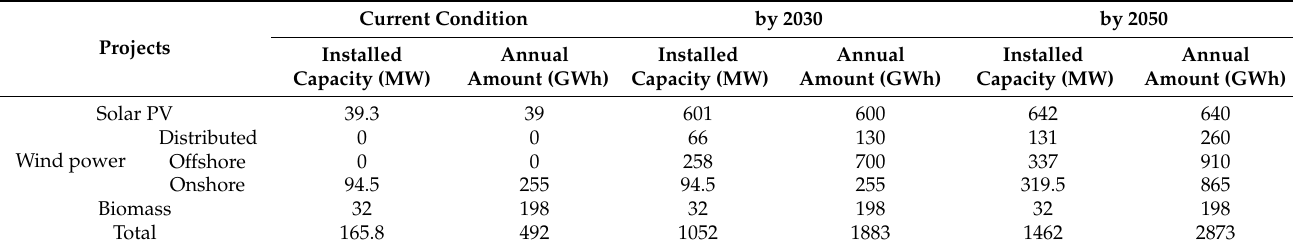
Table 17. Current and planned renewable energy